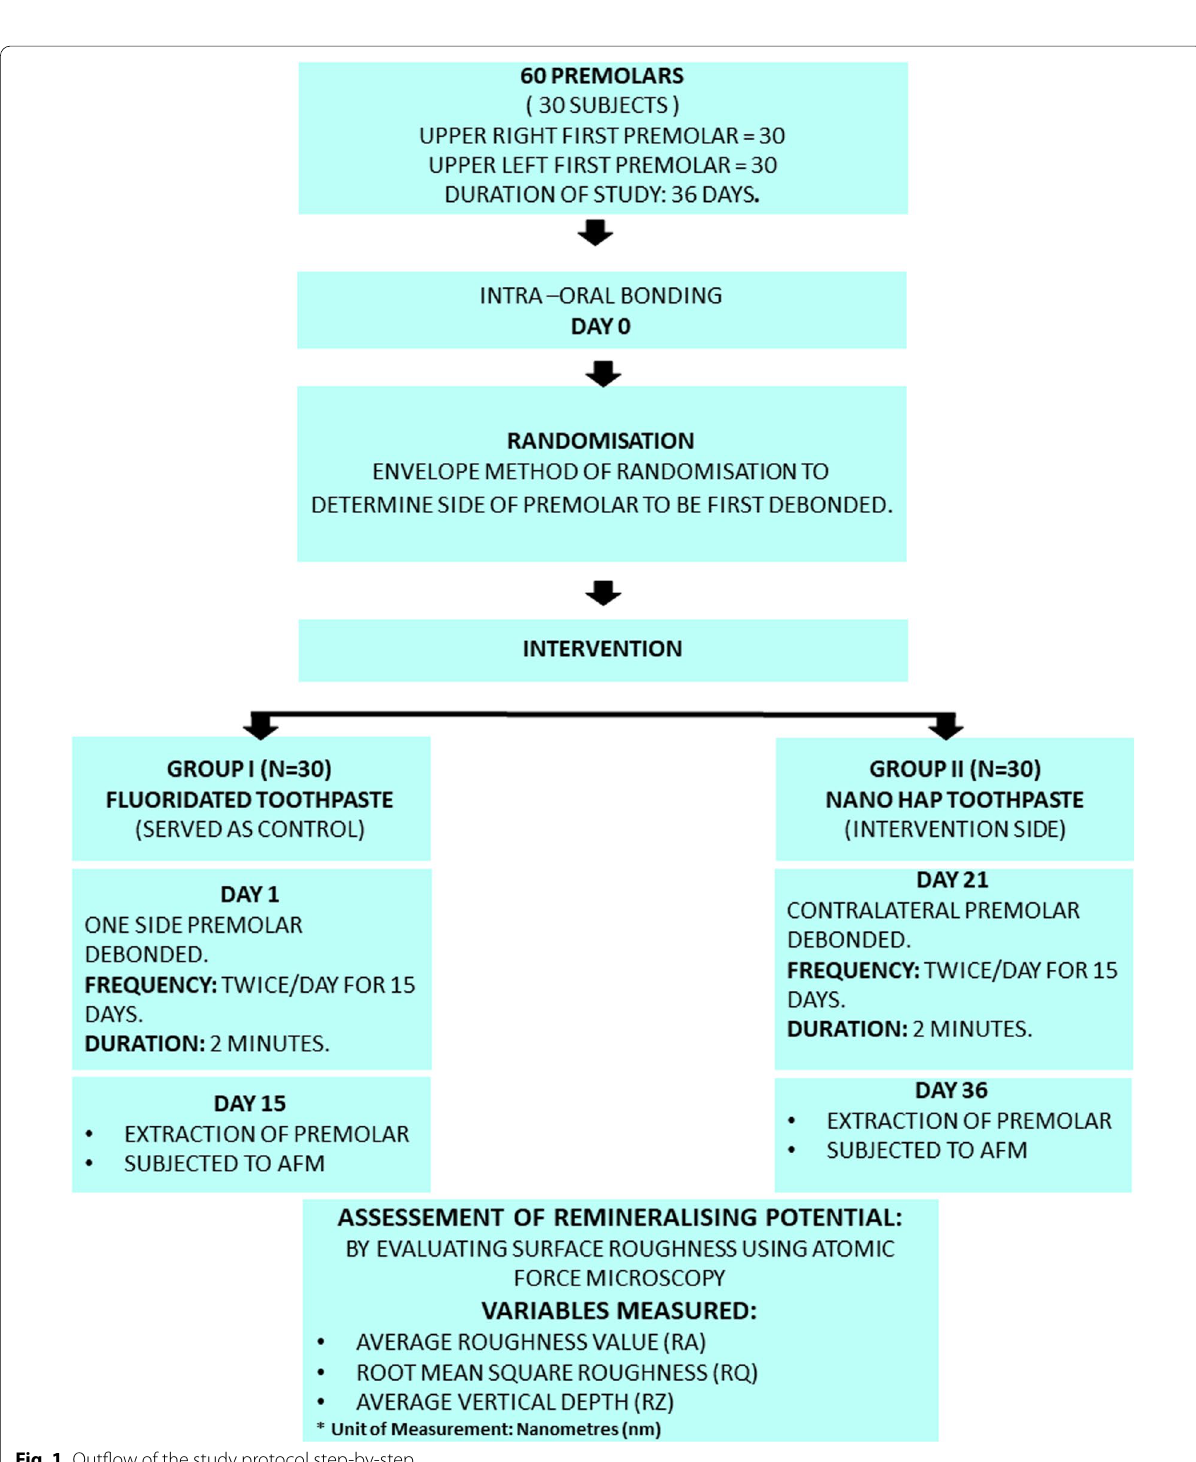
Fig. 1 Outflow of the study protocol